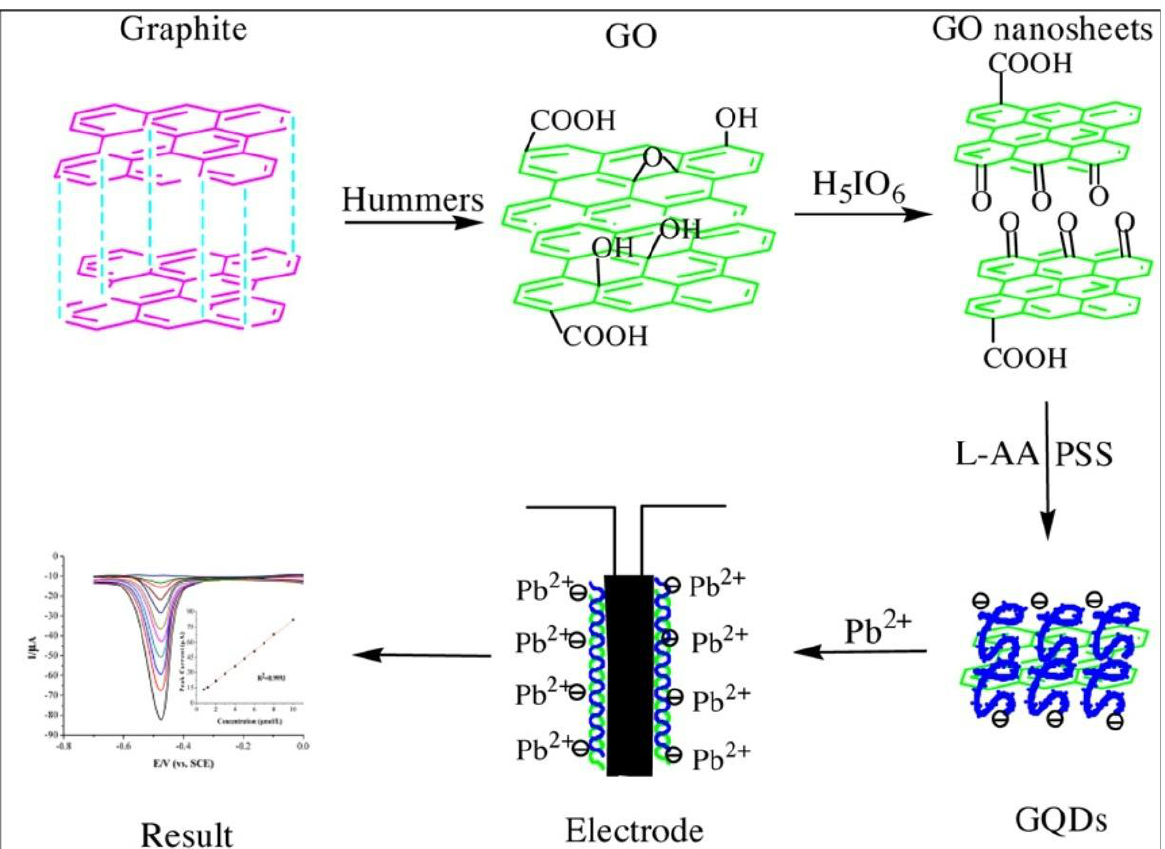
Figure 9. Schematic representation for the synthesis of GQDs by oxidative cleavage, a top-down approach. Reprinted from Ref. [98], Copyright (2014), with permission from